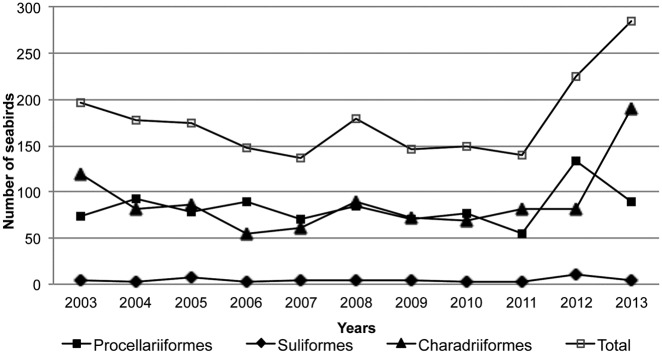
Number of seabirds admitted yearly to the Tafira Wildlife Rehabilitation Center (2003–2013) distributed by taxonomic order.